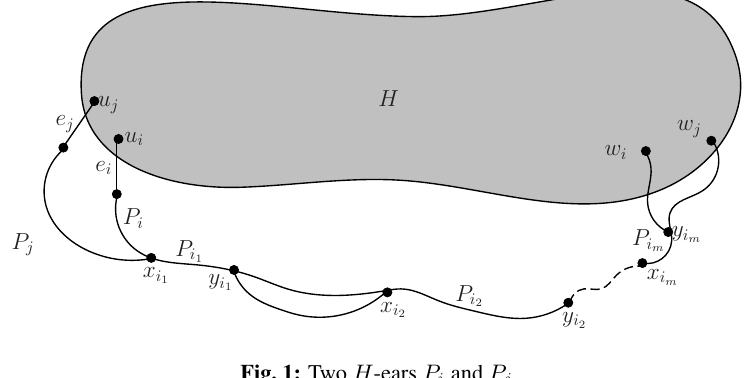
Fig. 1: Two H -ears P i and P